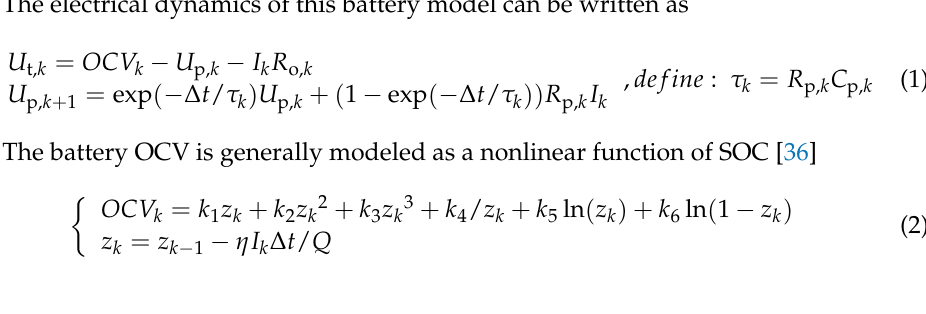
Figure 1. First-order resistor-capacitor battery model.